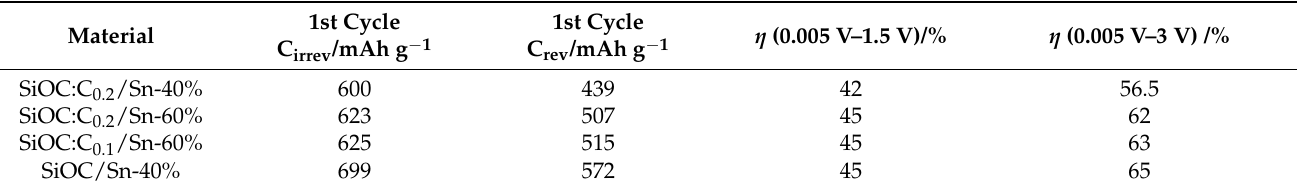
Table 2. Selected electrochemical results. Coulombic efficiencies η within 0.005 V–1.5 V and 0.005 V–3